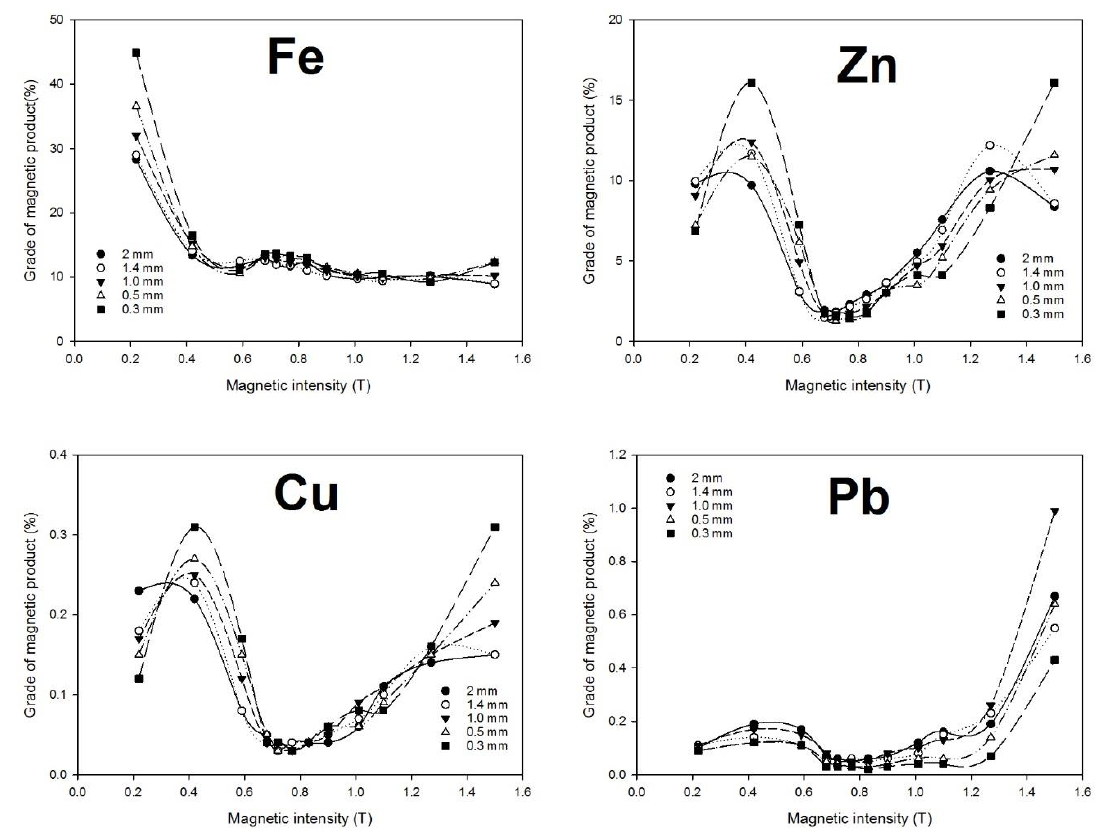
Figure 5. Grade of target elements in magnetic products that were extracted sequentially at low magnetic intensity and maximum feed-sample particle size.